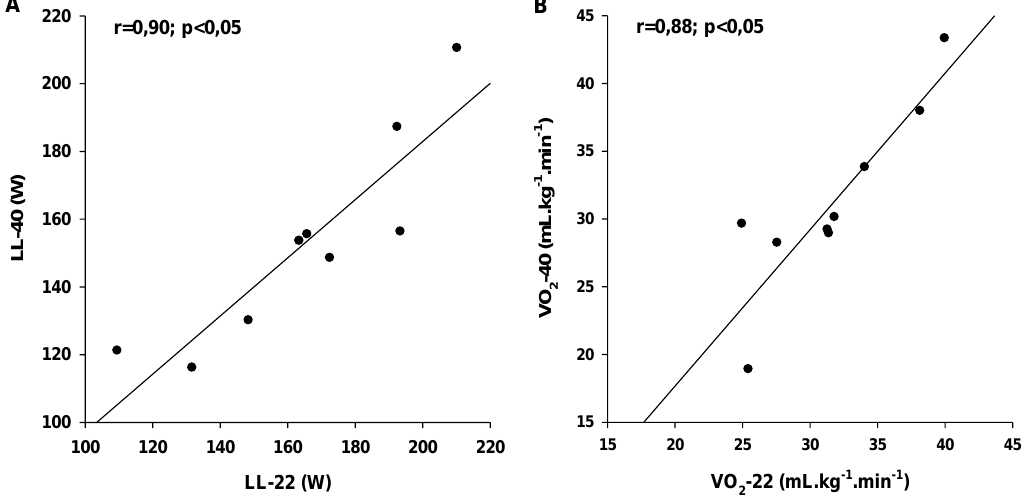
Figura 2. Correlação entre a potência no limiar de lactato identificado a 22ºC (LL-22) e 40ºC (LL-40) (A) e entre o consumo de oxigênio correspondente ao LL-22 (VO